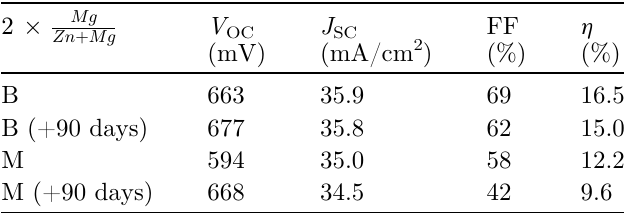
Table 3. PV parameters of devices with KCN and CBD- CdS alike surface treatment, see Figures 3a and 3b. All devices have buffer layers of ALD deposited Zn 28 nm.